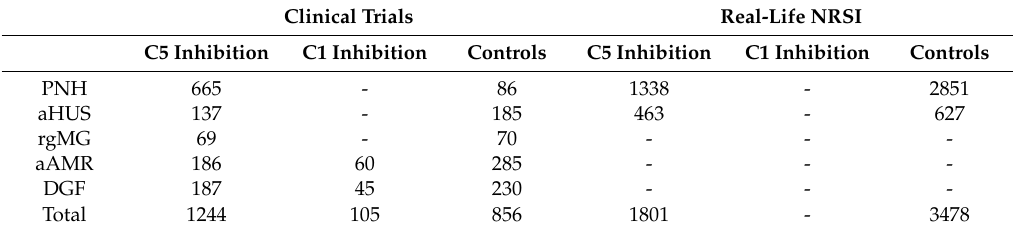
Table 2. Number of participants from studies for which numerical data were available for analysis.